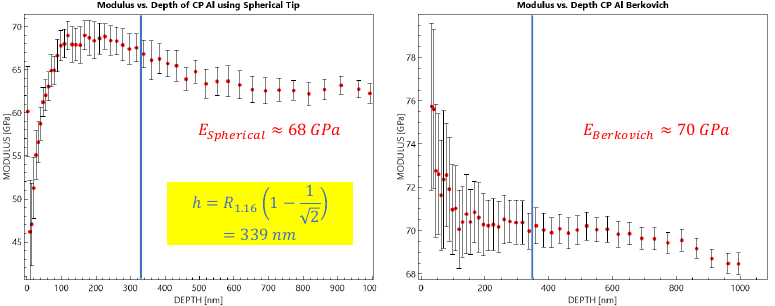
Figure 35. Comparison of elastic modulus measured using 1.16 µ m radius spherical tip as well as Berkovich indenter tip for commercially pure aluminum.